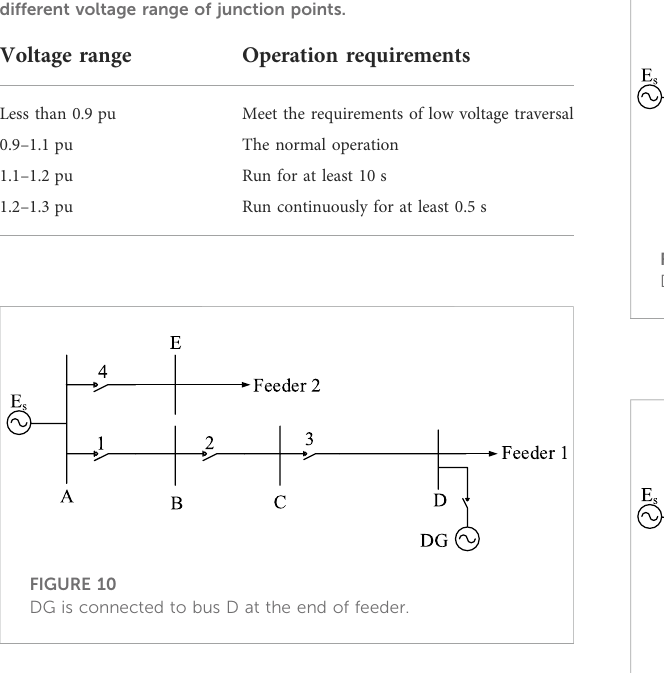
FIGURE 12 DG is connected to the terminal bus C of